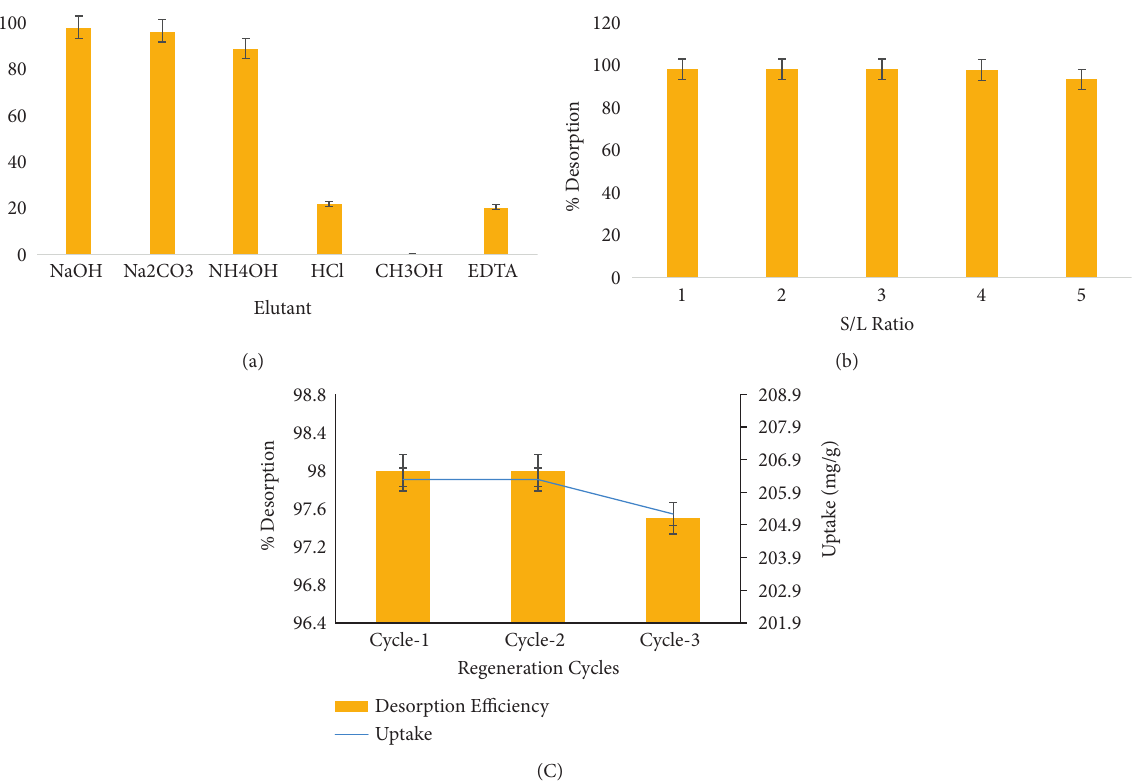
Figure 7: Desorption efficiency: (a) elutants; (b) S/L ratio; (C) regeneration